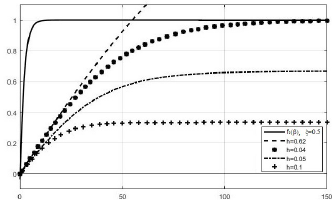
Figure 6. Graphics of the function f 1 ( β ) for ξ = 0 . 5 and function f 2 ( β ) for γ = 50 and vanish h . The existence of the root β 0 of Equation (2.8) depend on h